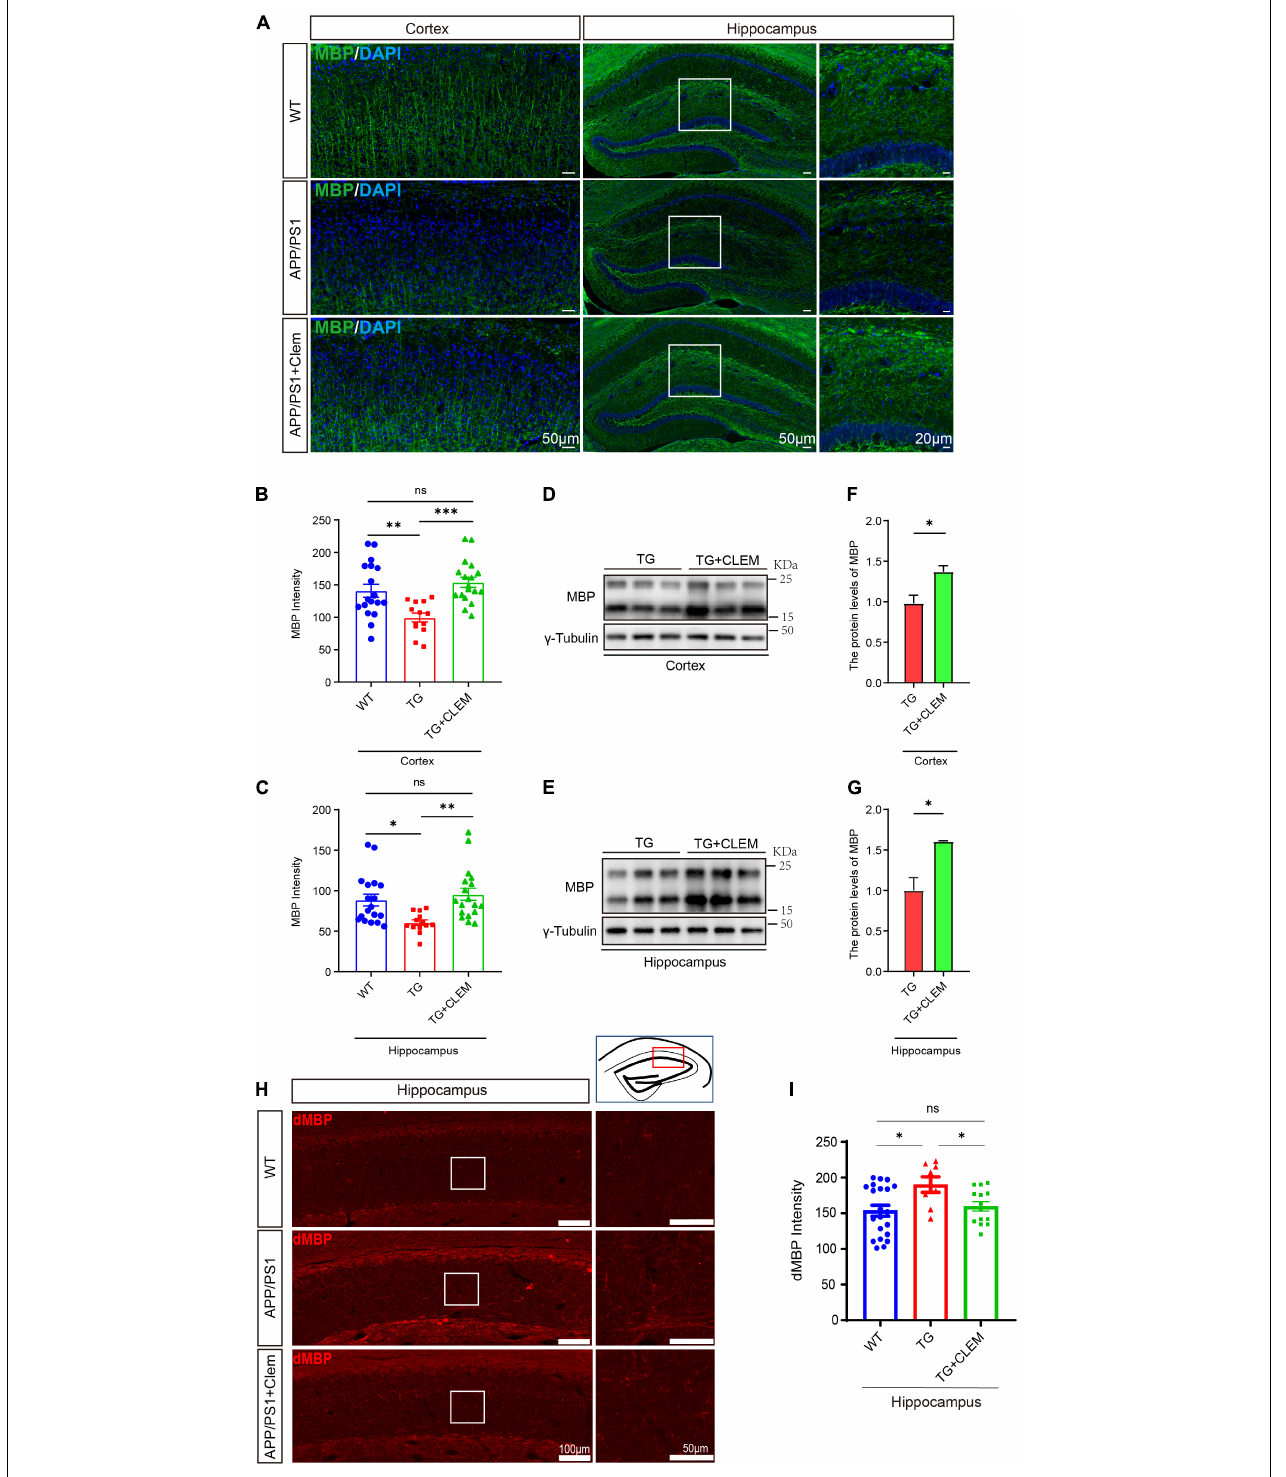
FIGURE 5 | Chronic treatment of clemastine enhances myelin formation in aged APP/PS1 mice brain. (A) Confocal images of immunolabeling MBP (green) in hippocampus/cortex of WT; APP/PS1 and APP/PS1 mice treated with clemastine. (B,C) Quantification of MBP signal intensity in cortex (B) or hippocampus (C) from immunostaining. (D,E) Western analysis of MBP levels in cortex (D) or hippocampus (E) of APP/PS1 or APP/PS1 mice treated with clemastine; γ -tubulin was served as loading control. (F,G) Quantification of replicated results shown in (D,E) , respectively. (H) Confocal images of immunolabeling dMBP in hippocampus of WT; APP/PS1 and APP/PS1 mice treated with clemastine. White box indicates magnified area of hippocampus. (I) Quantification of dMBP signal intensity shown in (H) . Values shown represent mean ± SE. ∗ p < 0.05, ∗∗ p < 0.01, ∗∗∗ p < 0.001, n = 4 mice per group for (B,C,H) and n = 3 mice per group for (F,G) , one-way analysis of variance with Student’s t-